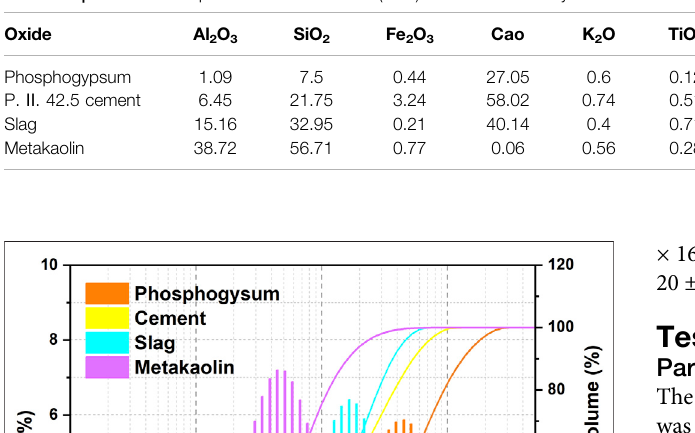
TABLE 1 | Chemical composition of main oxides (wt%) of raw materials by XRF.